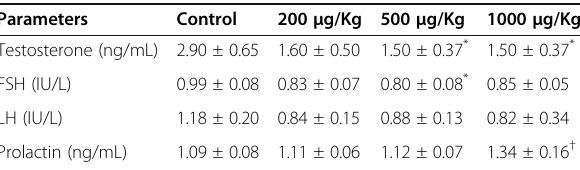
Table 6 Effect of ethyl acetate fraction of Waltheria indica Linn . root on reproductive hormones of male Wistar rats (Mean ± SD, n = 5 for each group)